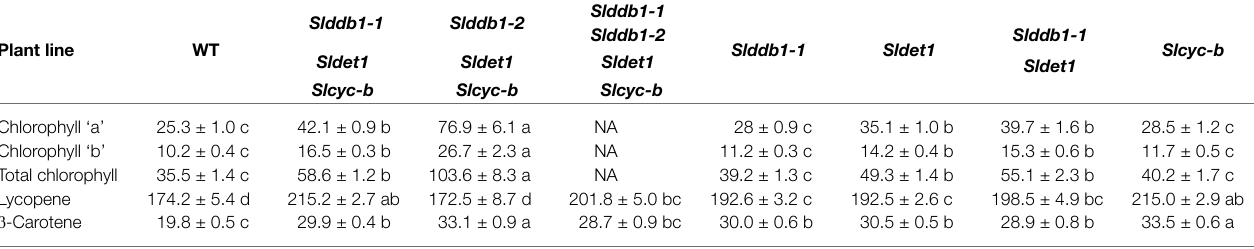
TABLE 1 | Chlorophyll contents in μ g/g FW of segregating T 3 and BC 1 F 3 generations at the mature green stage and lycopene and β -carotene contents at the red ripe stage.